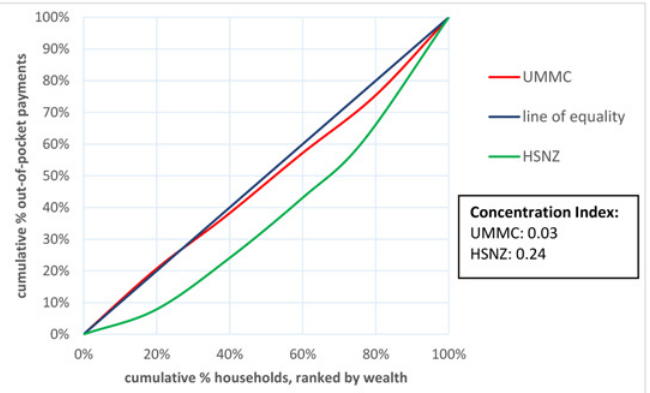
Fig 3. Concentration curves of out-of-pocket healthcare expenditure due to acute gastroenteritis requiring hospitalization. UMMC, University of Malaya Medical Centre; HSNZ, Hospital Sultanah Nur